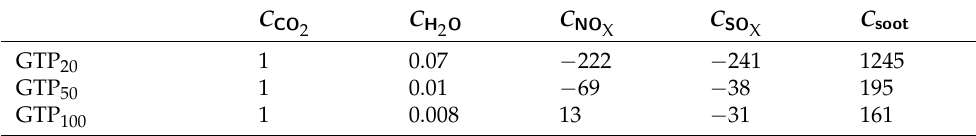
Table 2. GTP cost function